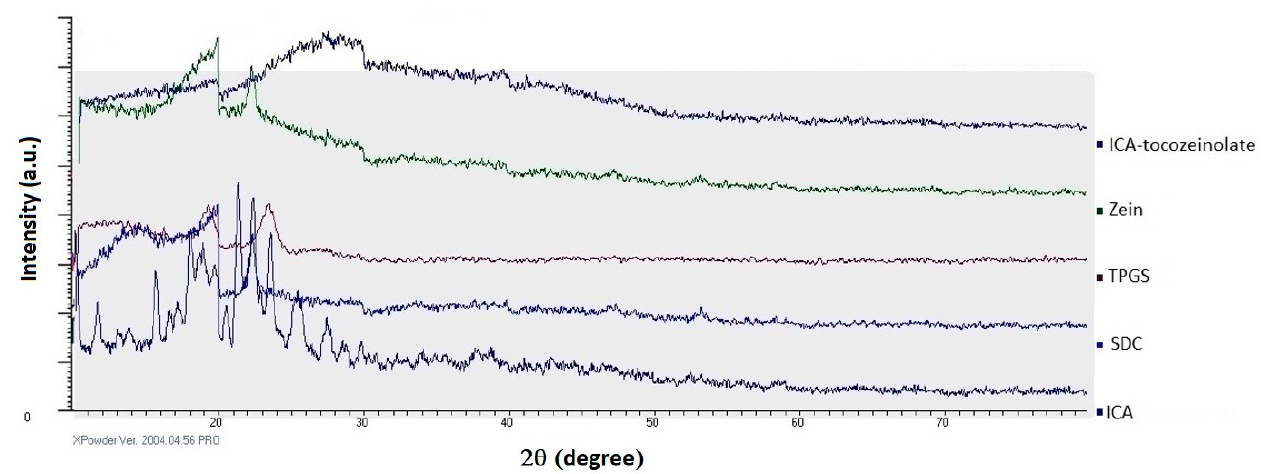
Figure 7. XRD diffraction analysis of the optimized ICA–tocozeinolate nanosphere formula and single formula components: ICA, SDC, TPGS, and zein.